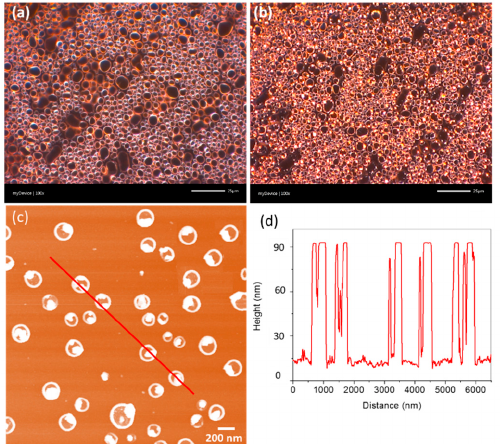
Figure 12. Optical Dark-field ( a , b ) and AFM ( c ) image of ZnO NP-loaded PMMA nanolayer on Si substrate. ( a ) PMMA layer without ZnO and ( b , c ) PMMA nanoholes embedded with ZnO NP, ( d ) AFM profile of ( c